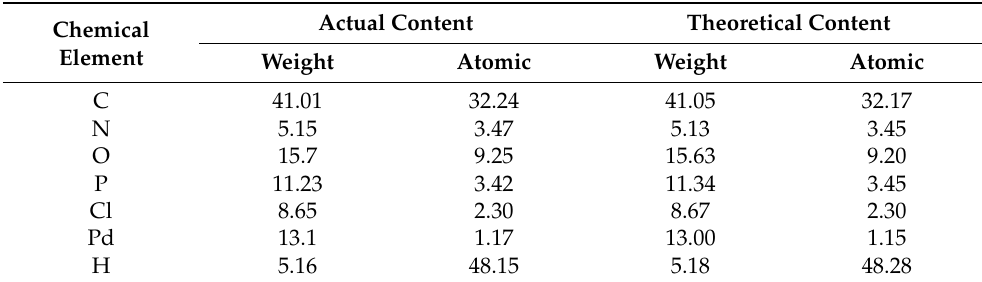
Table 1. Elemental composition of the palladium complex of the extractant, %.